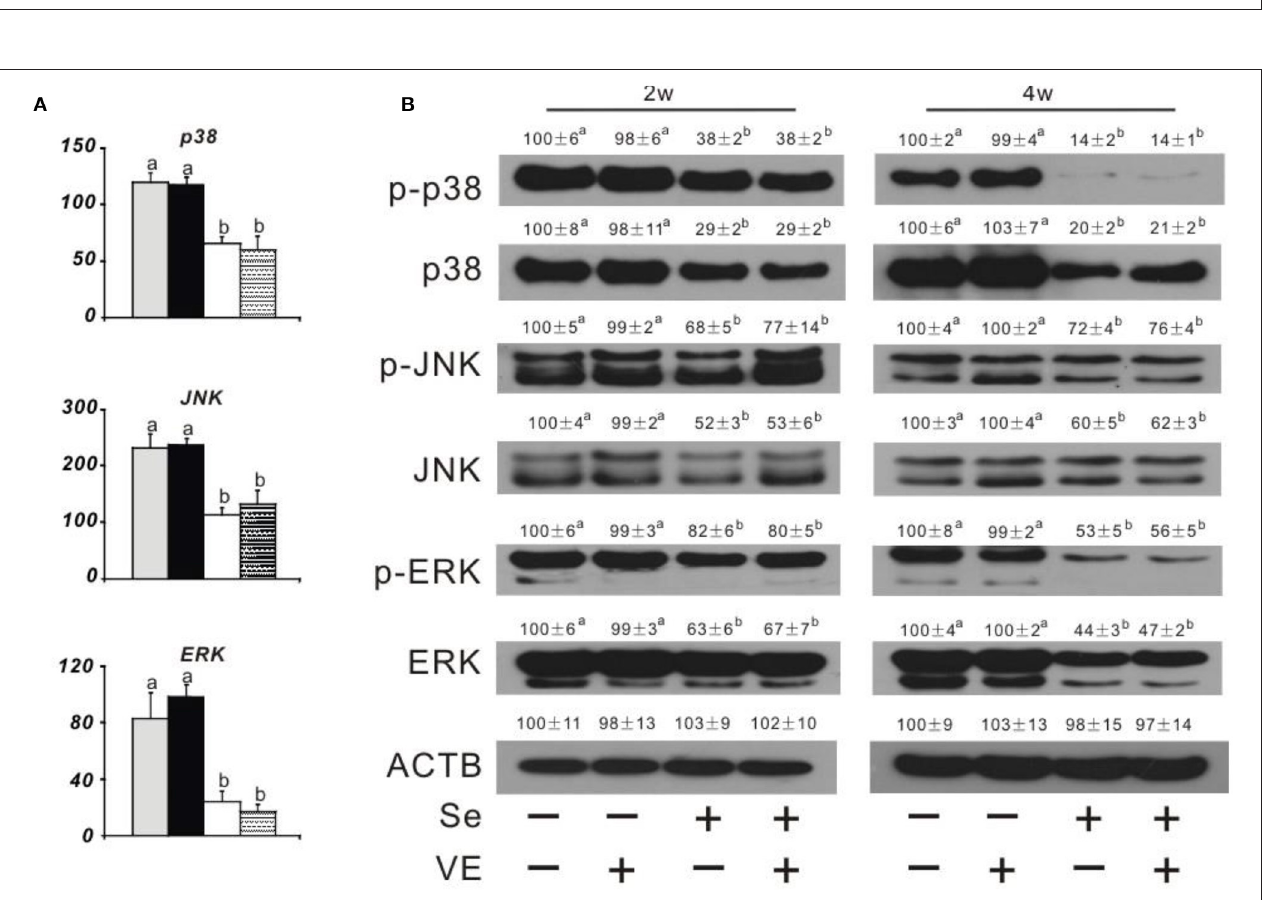
FIGURE 3 | Effects of dietary Se and VE on hepatic (A) relative mRNA abundance of p38, JNK, and ERK in chick at week 4 and (B) protein levels of phospho-p38 mitogen-activated protein kinase ( p -p38), p38 mitogen-activated protein kinase (p38), phospho-c-Jun N-terminal kinase (p-JNK), c-Jun N-terminal kinase (JNK), phospho-mitogen-activated protein kinase (p-ERK), extracellular signal-regulated kinase (ERK), and β -actin gene (ACTB) in chick at weeks 2 and 4. Data are means ± SE, n = 5 (A) or 3 (B) . Values within a given gene differ ( P < 0.05) without sharing a common superscript letter.